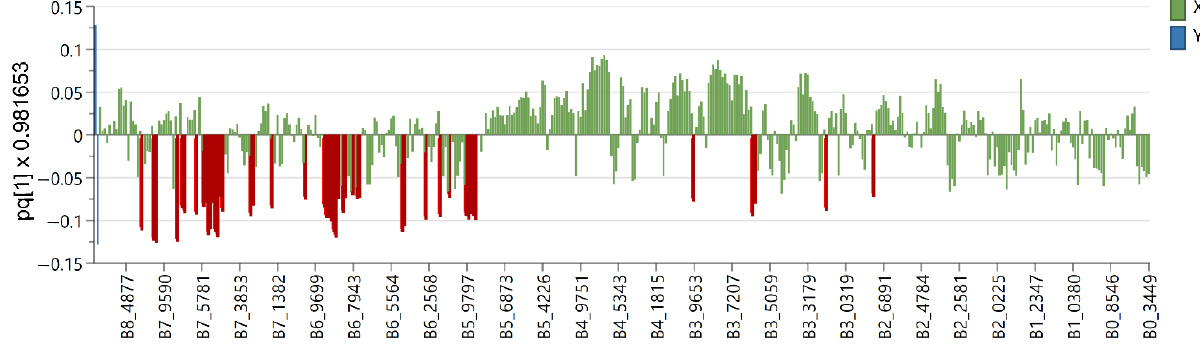
Figure 7. Loading plot with red and brown marked variables characteristic for E. panonnica (Y variables—loading vectors scaled to unit length) in comparison to other species (X variables—chemical shift), obtained from the OPLS-DA model.